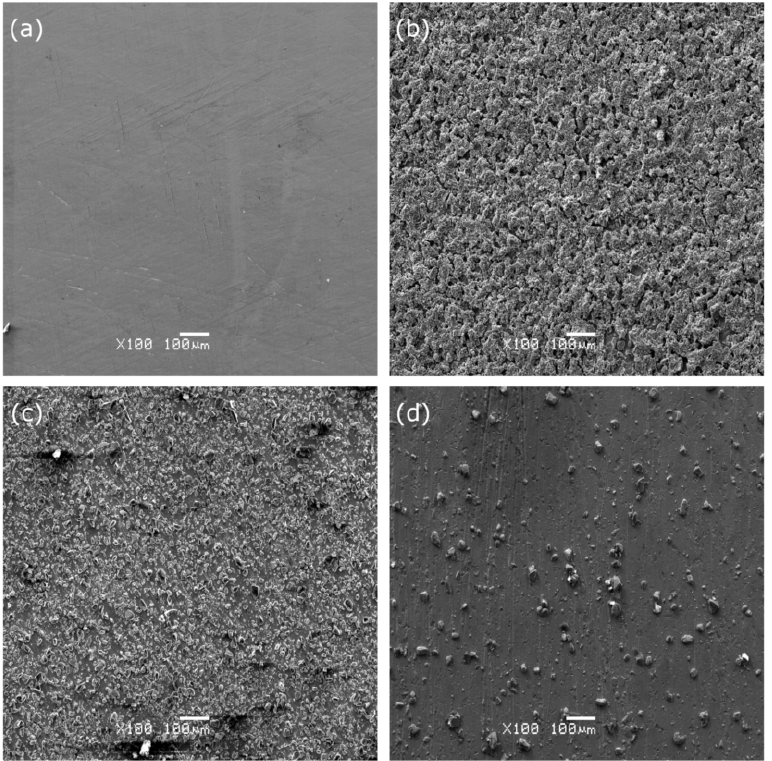
a-r PEG , ( c ) CFO Ni , ( d ) CFO Ni